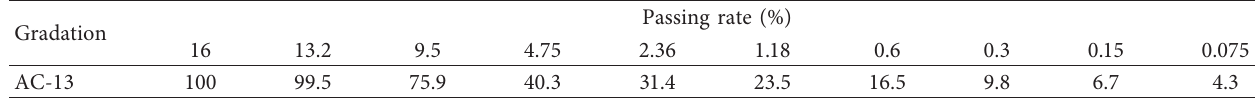
Figure 8: Comparison of Marshall section images: (a) section images; (b) before adjusted gradation; (c) second adjusted gradation. Table 6: Designed gradation of asphalt mixture.